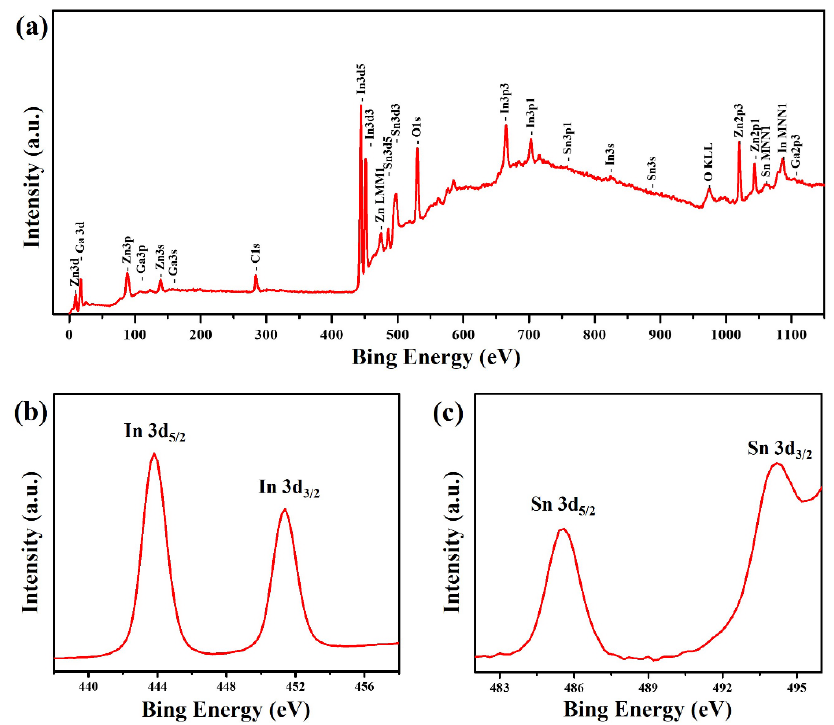
Figure 4. XPS spectra of the ZnO: Ga@ITO nanotowers: ( a ) survey spectrum, ( b ) In 3d, and ( c ) Sn 3d.